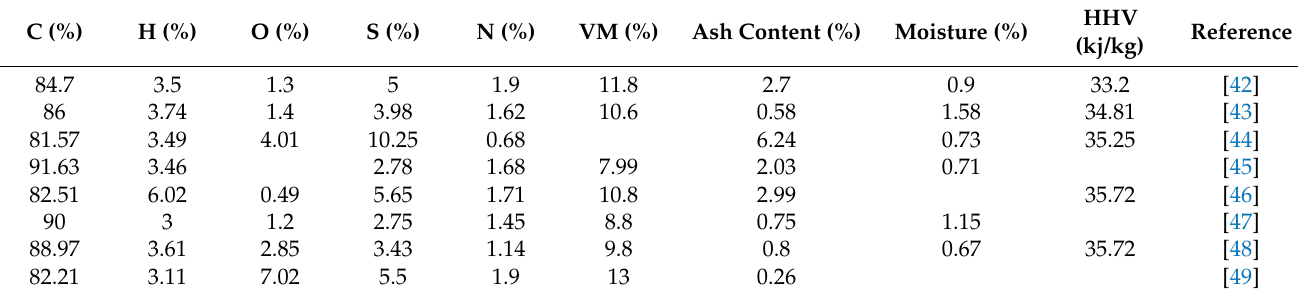
Table 9. Studies from literature review on the properties of pet